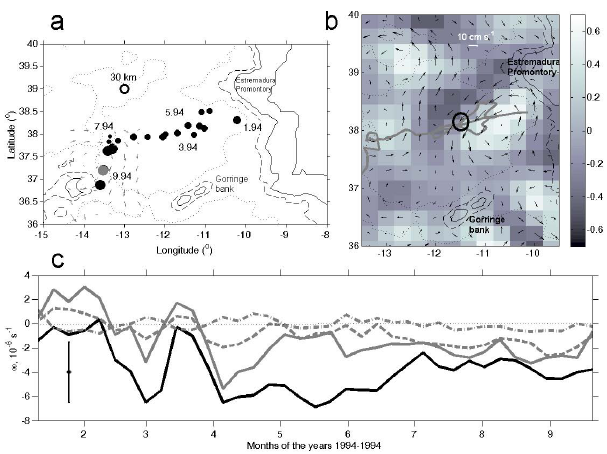
Fig. 3. Same as Fig. 1, but for the meddy Pinball (the direction of meddy movement is to west and then to south); (b) shows the AVISO derived geostrophic currents on